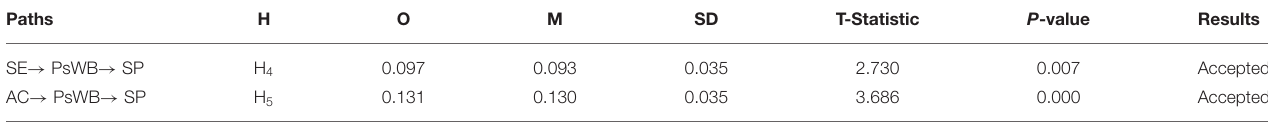
TABLE 6 | Indirect effects. Paths